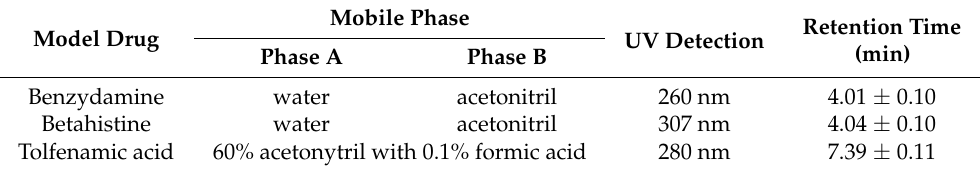
Table 1. Chromatographic conditions for determination of benzydamine, tolfenamic acid and be- tahistine. The mobile phase for BZ and BET was a mixture of Phase A and Phase B (80:20). pH was adjusted to 10.5 with triethyl